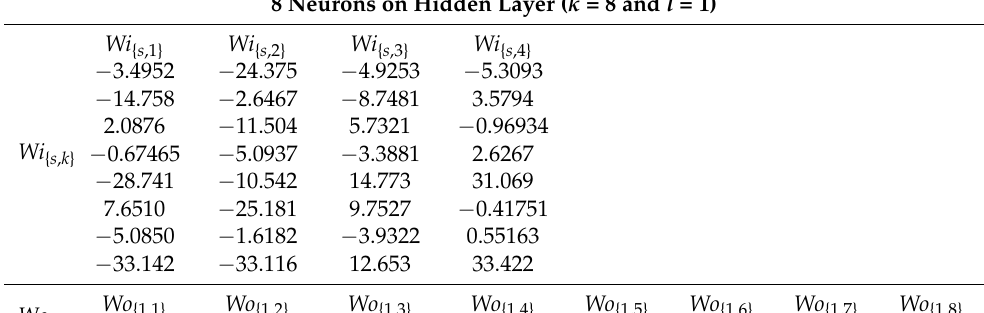
Table A4. Weights and biases for the ANN model predicting carbonylated proteins concentration. 8 Neurons on Hidden Layer ( k = 8 and l = 1)